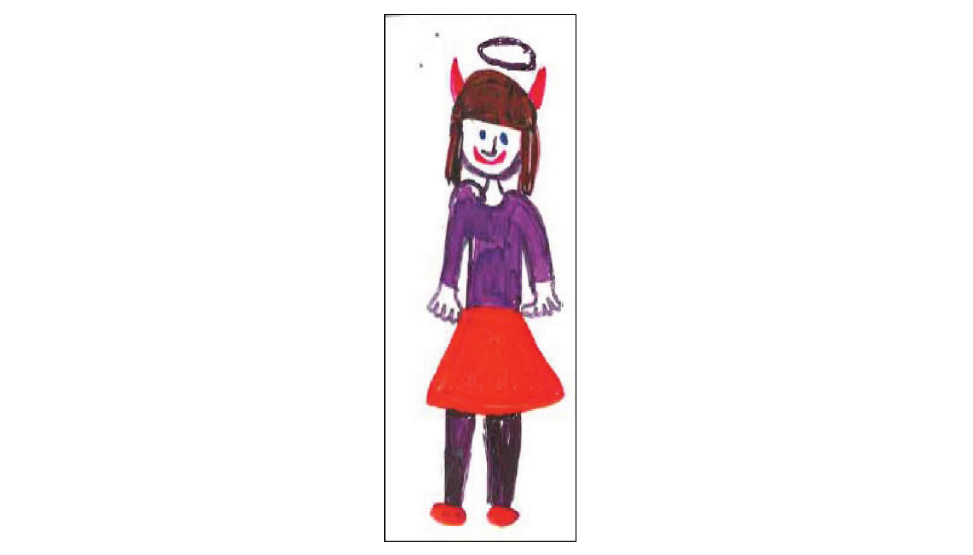
The young person’s juxtaposition of halo and devil horns is a powerful visualization of the confusion and uncertainty associated with a new foster placement. In the film,